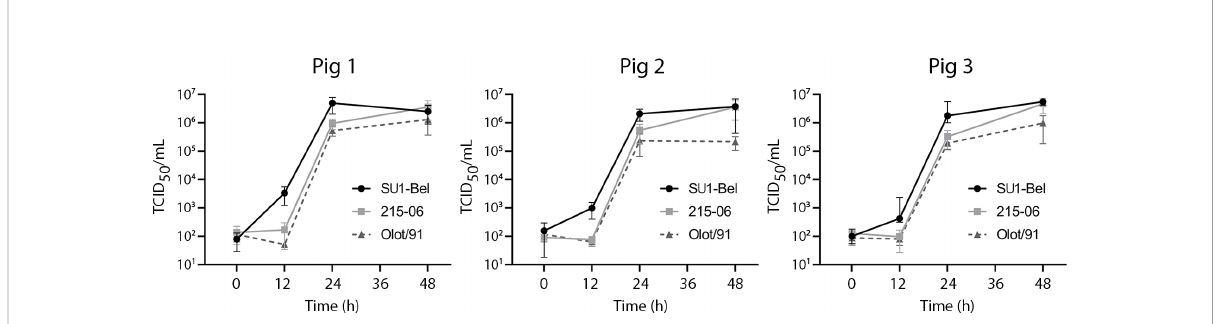
FIGURE 1 Comparative growth kinetics of PRRSV-1 strains of different virulence in porcine BMDM. Cells from three pigs were infected (MOI 0.01) with either PRRSV-1 strain SU1-Bel, 215-06, or Olot/91 for 48 h. Supernatant was sampled at 0, 12, 24 and 48 hpi and virus titrated by TCID 50 . Experiments were performed on three separate occasions. Data is presented as the mean +/- standard